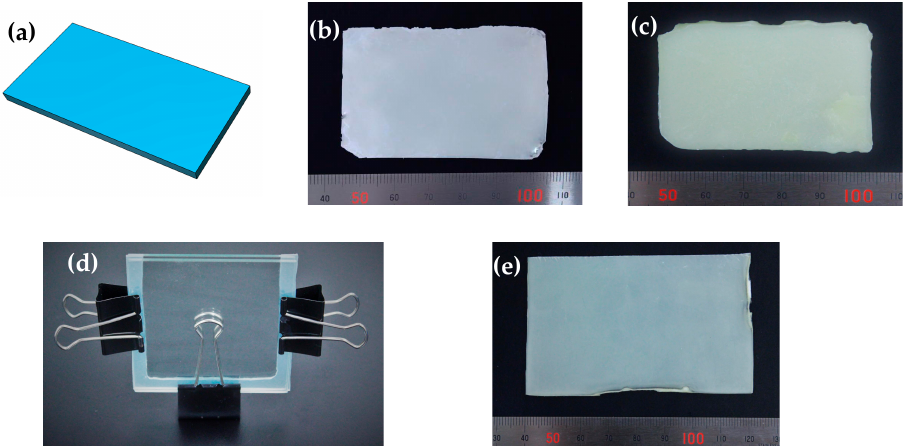
Figure 4. The 3D sheet model designed by 123D Design ( a ); P(SA-DMAA) gel sheet of 3DP 0.25 (printed on LumiForge) ( b ); Post-UV 3DP 0.25 (after post-UV treatment) ( c ); and Mold 0.25 ( e ); prepared using conventional mold ( d ).